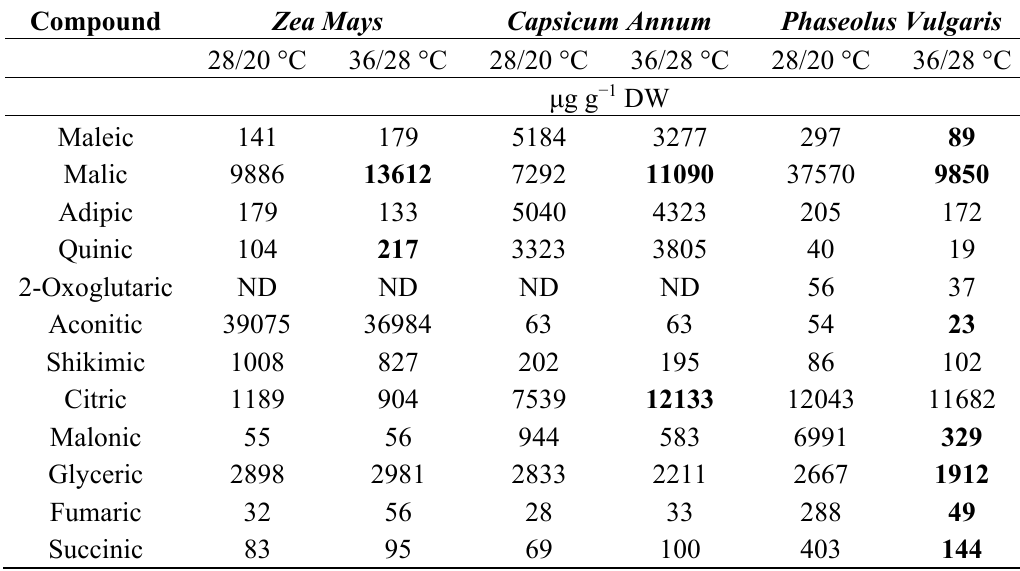
Table 3. Species differences showing effects of supra-optimal growth temperatures on various foliar organic acids. Plants were grown for a minimum of three weeks with 28/20 or 36/28 °C growth temperatures. Sampled leaves were analyzed by a GC-MS procedure and values in bold print within species differed at p ≤